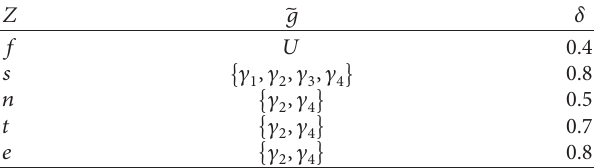
Table 4: Table representation of hybrid structure 􏽥 g Z 􏽥